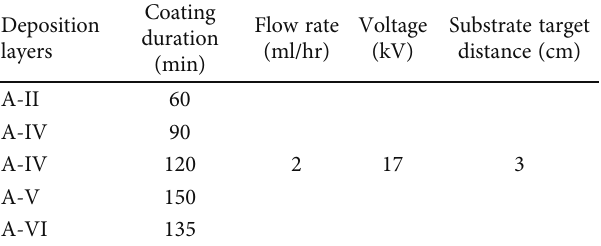
Figure 1: Pictorial representation of synthesis and deposition of MoS Table 1: Deposition parameters for